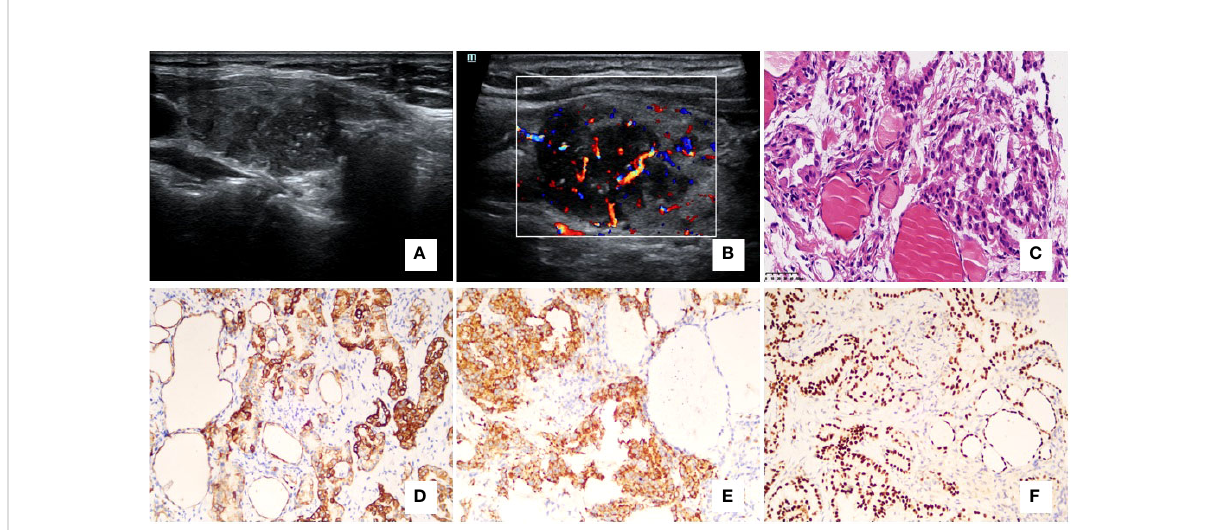
FIGURE 2 Case 4, a 51-year-old woman had a 3-year history of lung adenocarcinoma. Ultrasonography of the right lobe (A) showed an irregular, hypoechoic nodule with microcalci fi cations. Doppler ultrasonography showed rich intra-tumoral vascularity (B) . The cytology result was atypia with an undetermined source, and then a core needle biopsy was performed. The histology showed the papillary and tubular-acinar architecture and malignant cuboidal to columnar tumor cells with mild nuclear atypia [ (C) – 400x]. In immunohistochemistry, the malignant cells were positive for CK7 ( D – 200x), Napsin A [ (E) – 200x], and TTF1 ( F – 200x). (A, B) ultrasonography; (C) hematoxylin-eosin staining; (D – F)